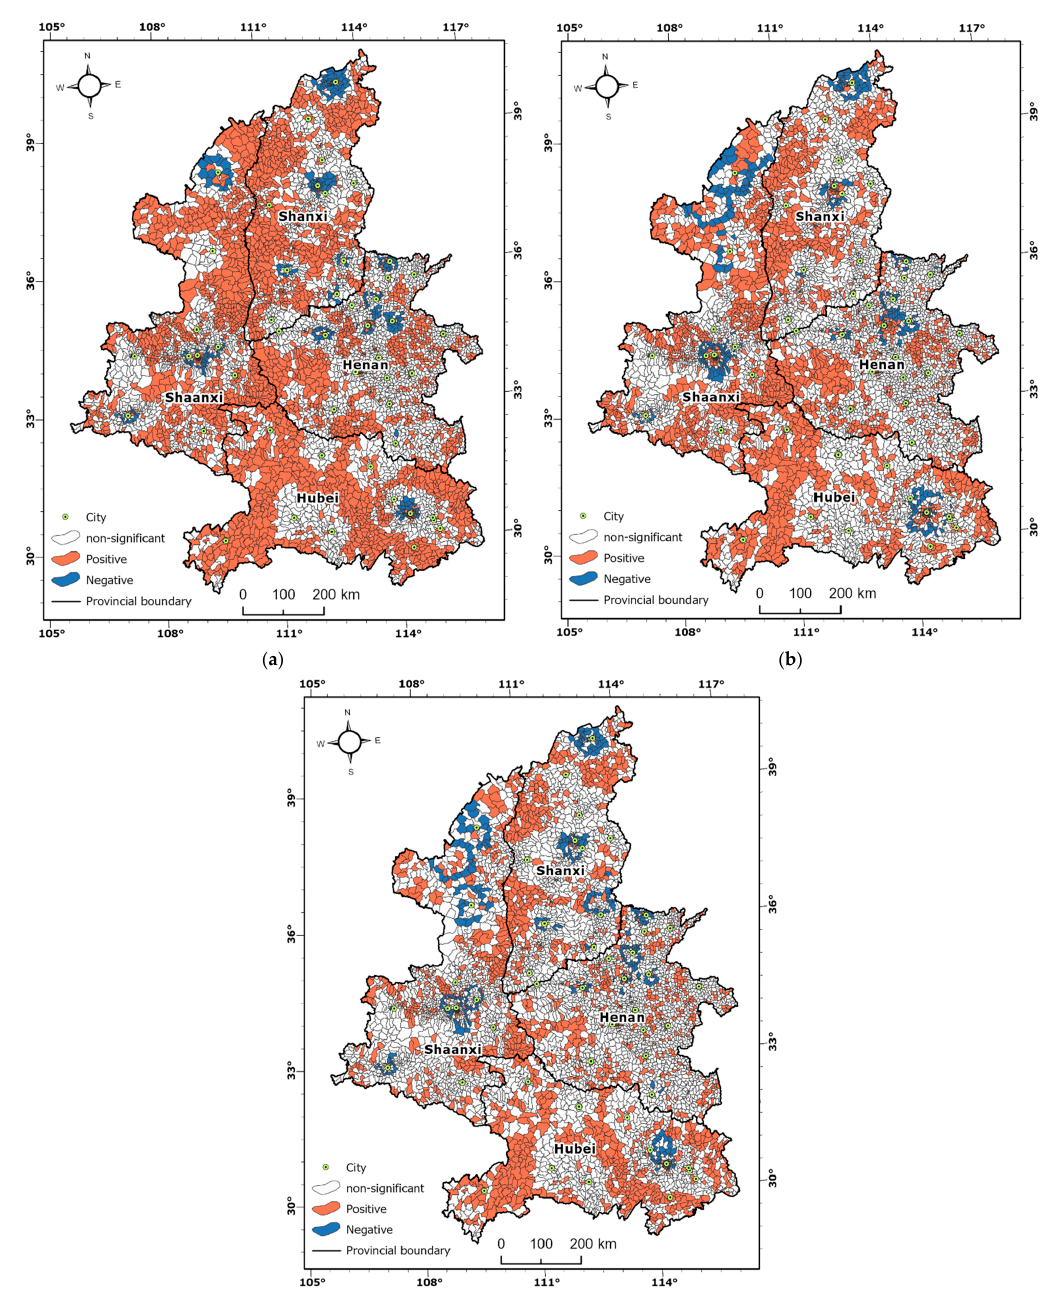
Figure 9. Spatial association mapping between the township development and hub level: ( a ) Correlation with the mean value of nighttime light; ( b ) Correlation with sum value of nighttime light; ( c ) Correlation with sum value of nighttime highlights.